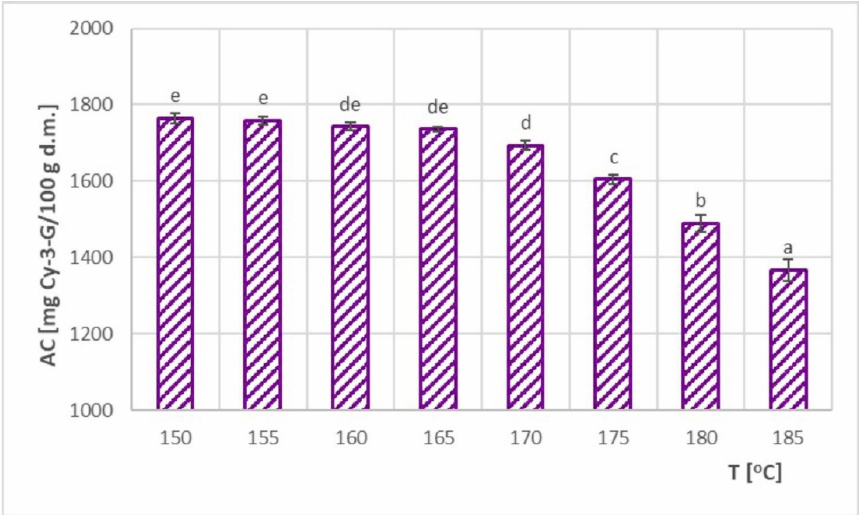
Figure 11. Anthocyanin content (AC) in spray-dried chokeberry juice at different inlet air temperatures (T); (a, b, c, d, e — different letters show significant differences between mean values ( p ≤ 0.05)).